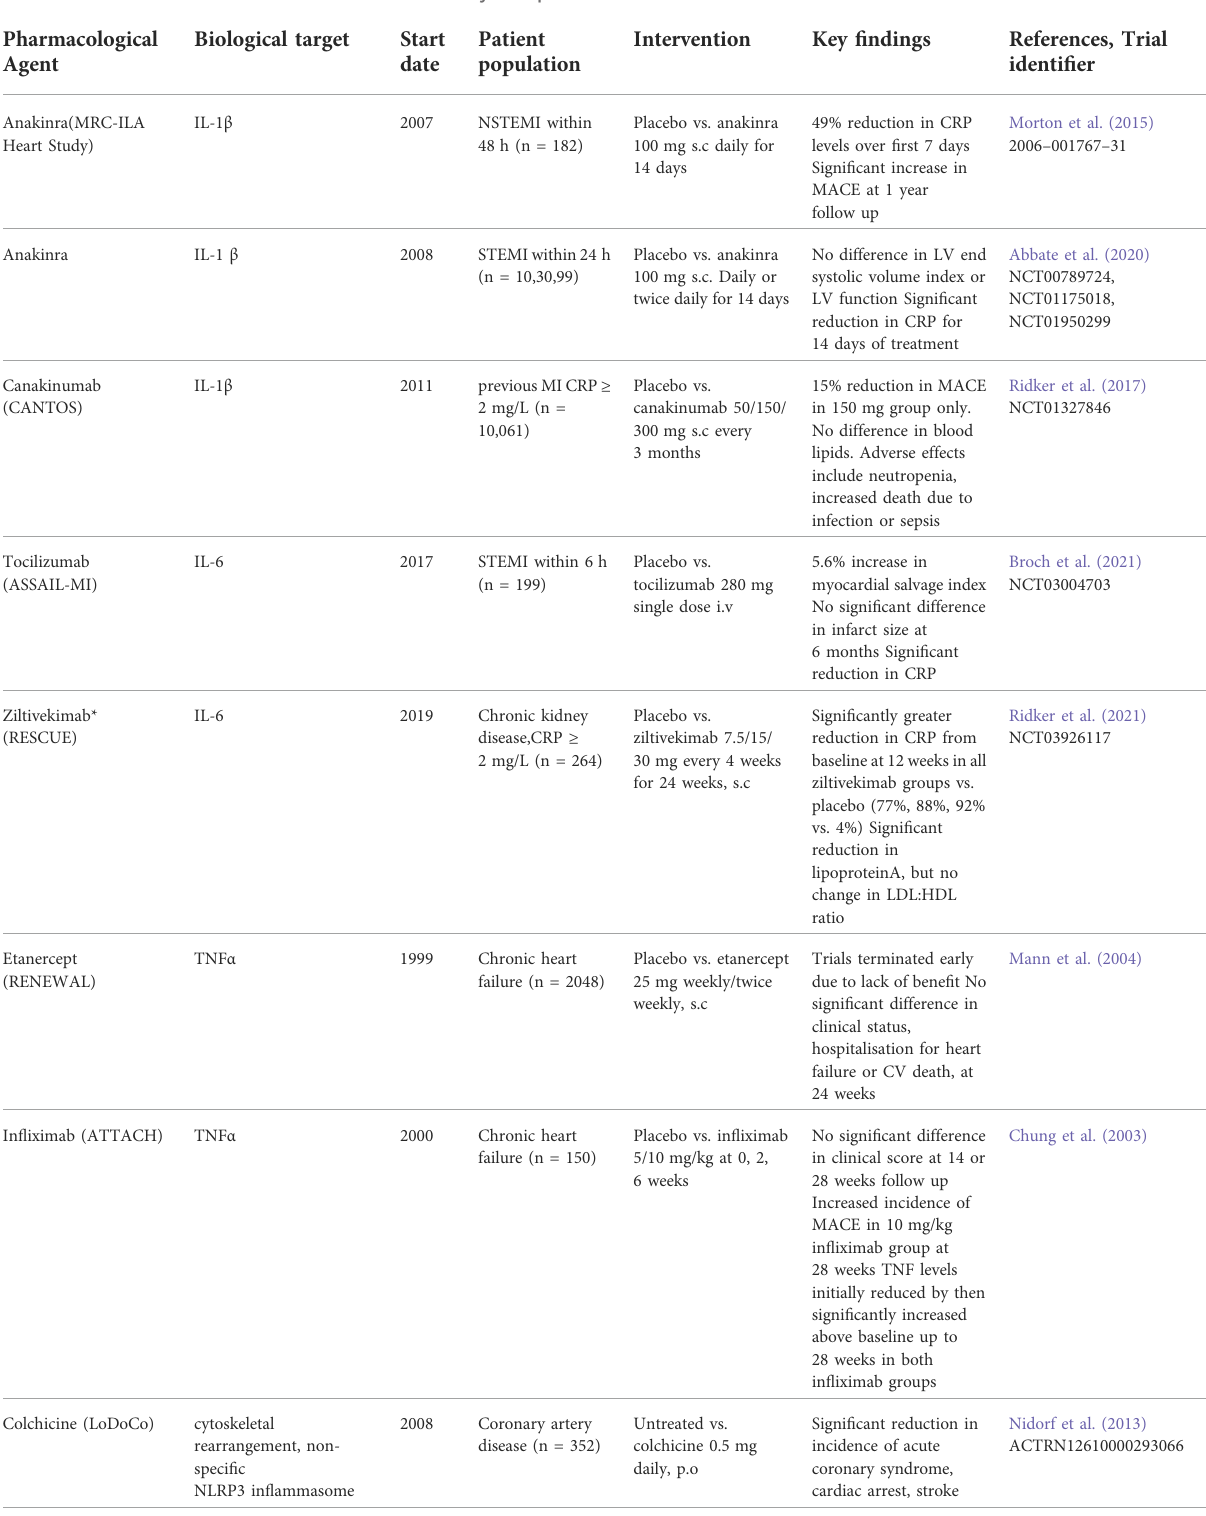
TABLE 1 Cardiovascular Clinical Trials of anti-in fl ammatory